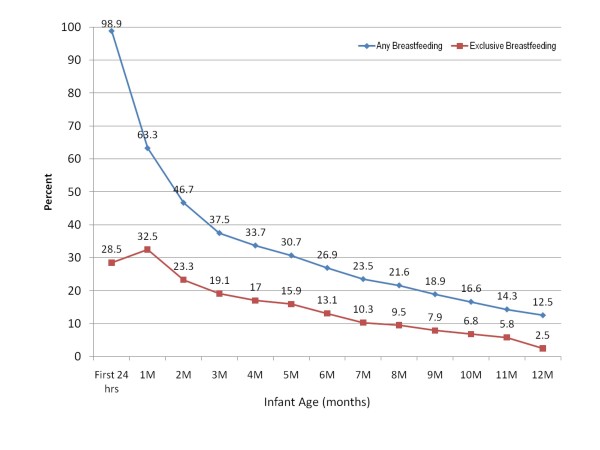
The proportion of mothers still providing any breastfeeding and exclusively breastfeeding at monthly time intervals.